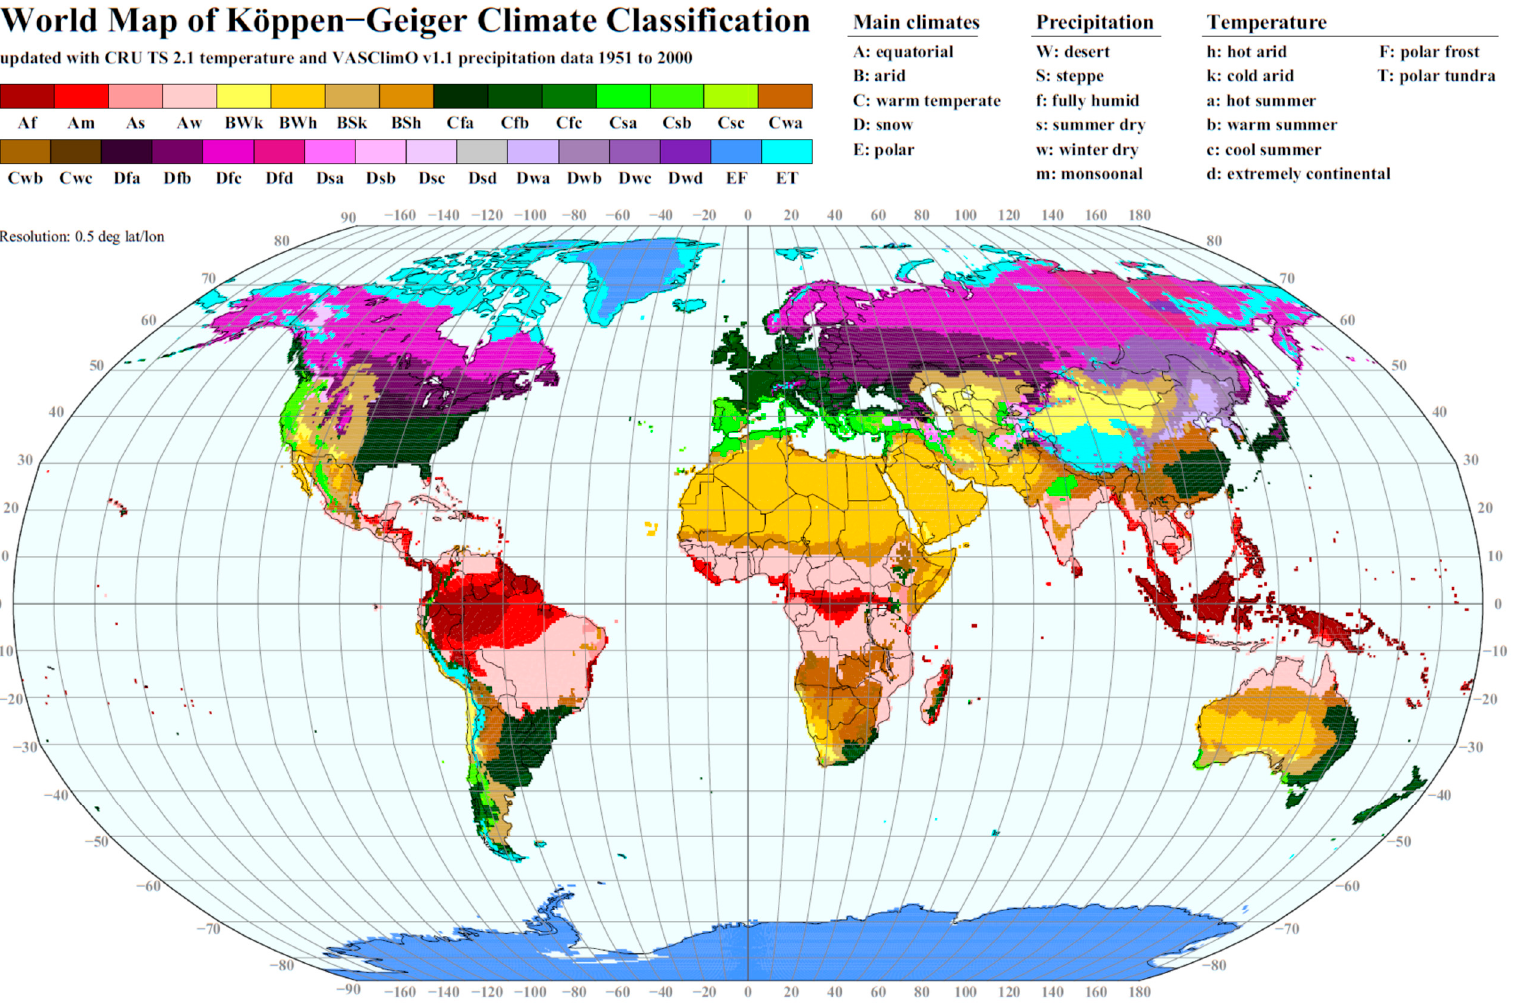
Figure 2. World Map of Köppen-Geiger climate classification updated with mean monthly CRU TS 2.1 temperature and VASClimO v1.1 precipitation data for the period 1951 to 2000 on a regular 0.5 degree latitude/longitude grid [19].